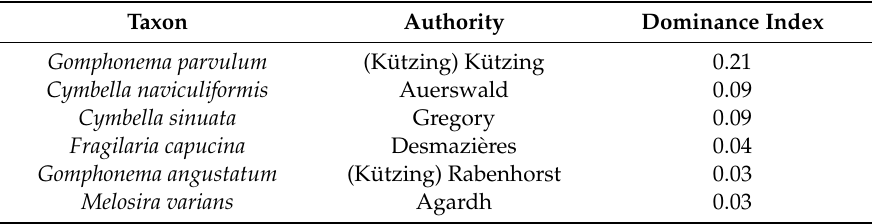
Table 2. Dominant species of benthic diatom in the Wutong River.